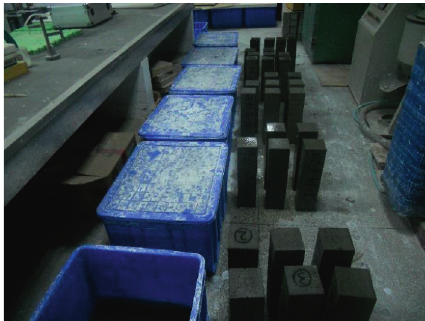
Figure 1: Test of sodium sulfate attack on concrete under drying- wetting